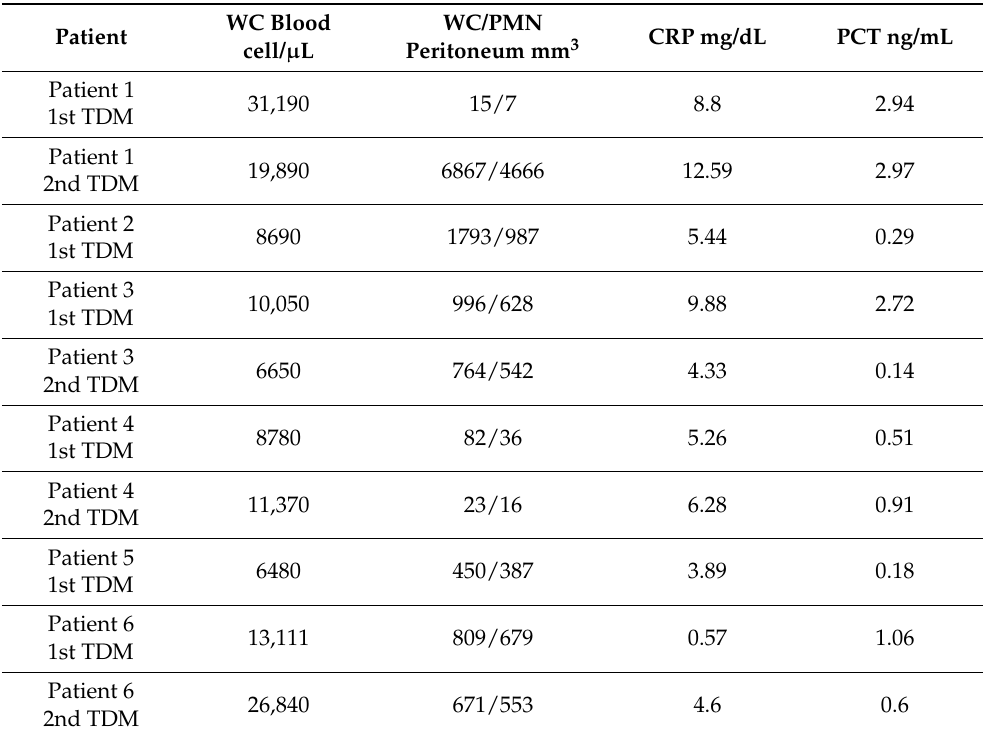
Table 2. Blood tests associated with dosage of amphotericin-B